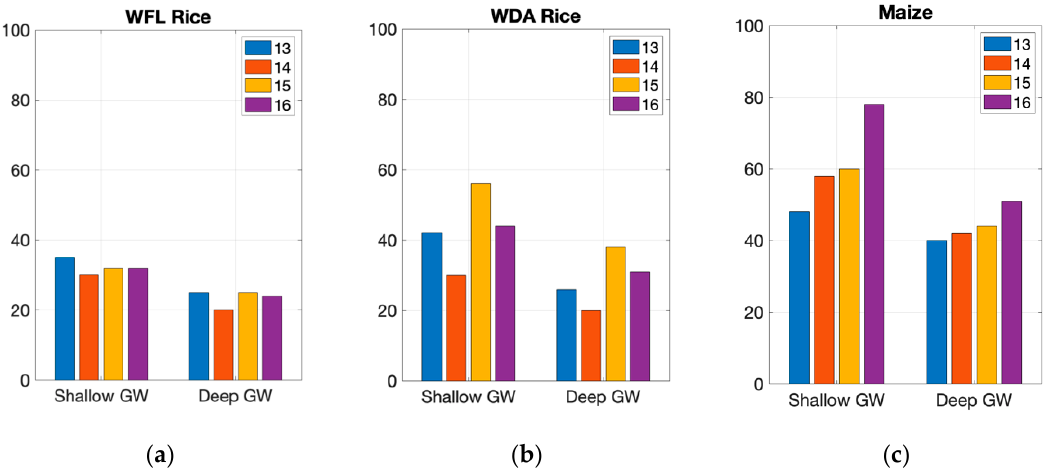
Figure 10. WUE of the three main crops in the case of shallow and deep GWL zones for the period 2013–2016: ( a ) WFL rice; ( b ) WDA rice; ( c ) Maize. Table 4. Average water balance terms resulting from simulations and WUE of the agricultural area referred to the different land use types calculated for the cropping season (15 April–15 September) for the period 2013–2016. WUE averaged over areas characterized by shallow and deep GWLs are reported in brackets; average rainfall value was 320 mm.